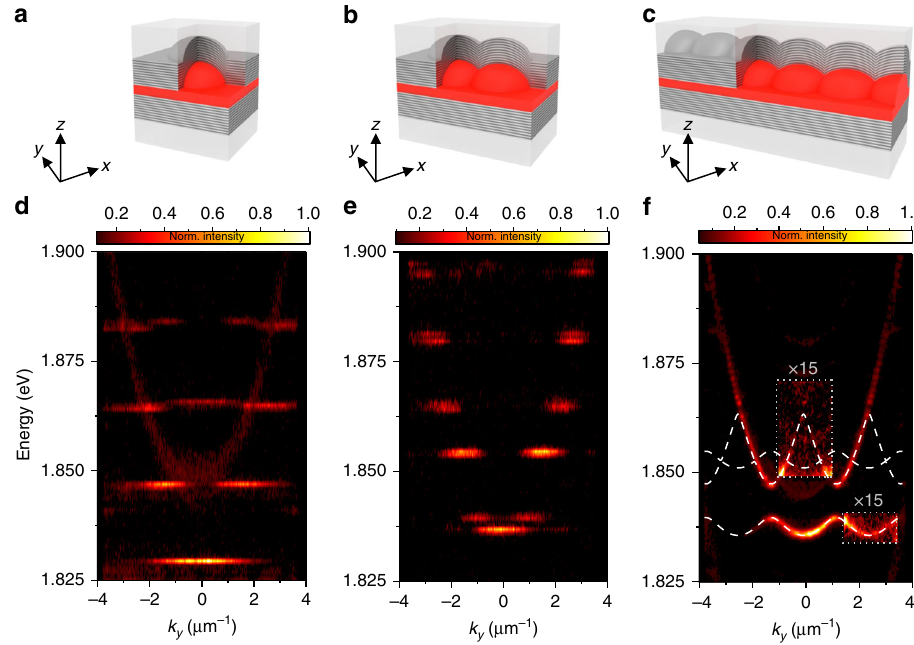
Fig. 1 Schematic images and angle-resolved measurements of our device. a – c Artistic illustration of single trap ( a ), molecular con fi guration ( b ), and one- dimensional lattice ( c ). The hemispheric indentations are fi lled with the “ mCherry ” proteins (red). d – f Angle-resolved photoluminescence spectrum of a single trapping site ( d ), as well as a molecular con fi guration ( e ) and the one-dimensional lattice ( f ), proving the formation of a bandgap polariton spectrum resulting from evanescent coupling between the sites. White lines show calculated single-particle energy bands in the effective periodic potential of the depth − 270 meV and in the gray lined area the intensity is enhanced 15-fold. The measurements are recorded at a detuning between the cavity photon and exciton energy of Δ = E C − E X = − 100 meV (at k = 0 of the ground Bloch band). Note that slight variations in the energies of the emission spectra in d – f arise from a modest variation in the detuning between the